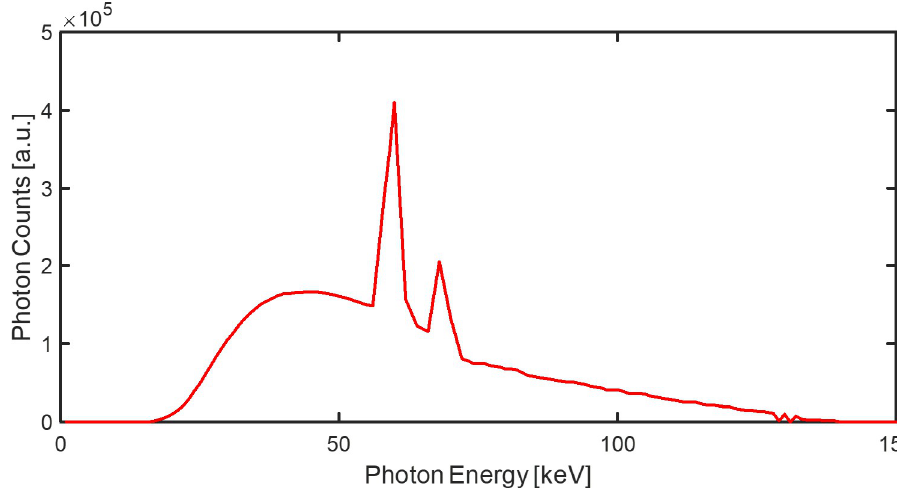
Fig 4. TASMIP X-ray spectrum at a tube voltage of 140 kV with 2-mm thick Al filtration.